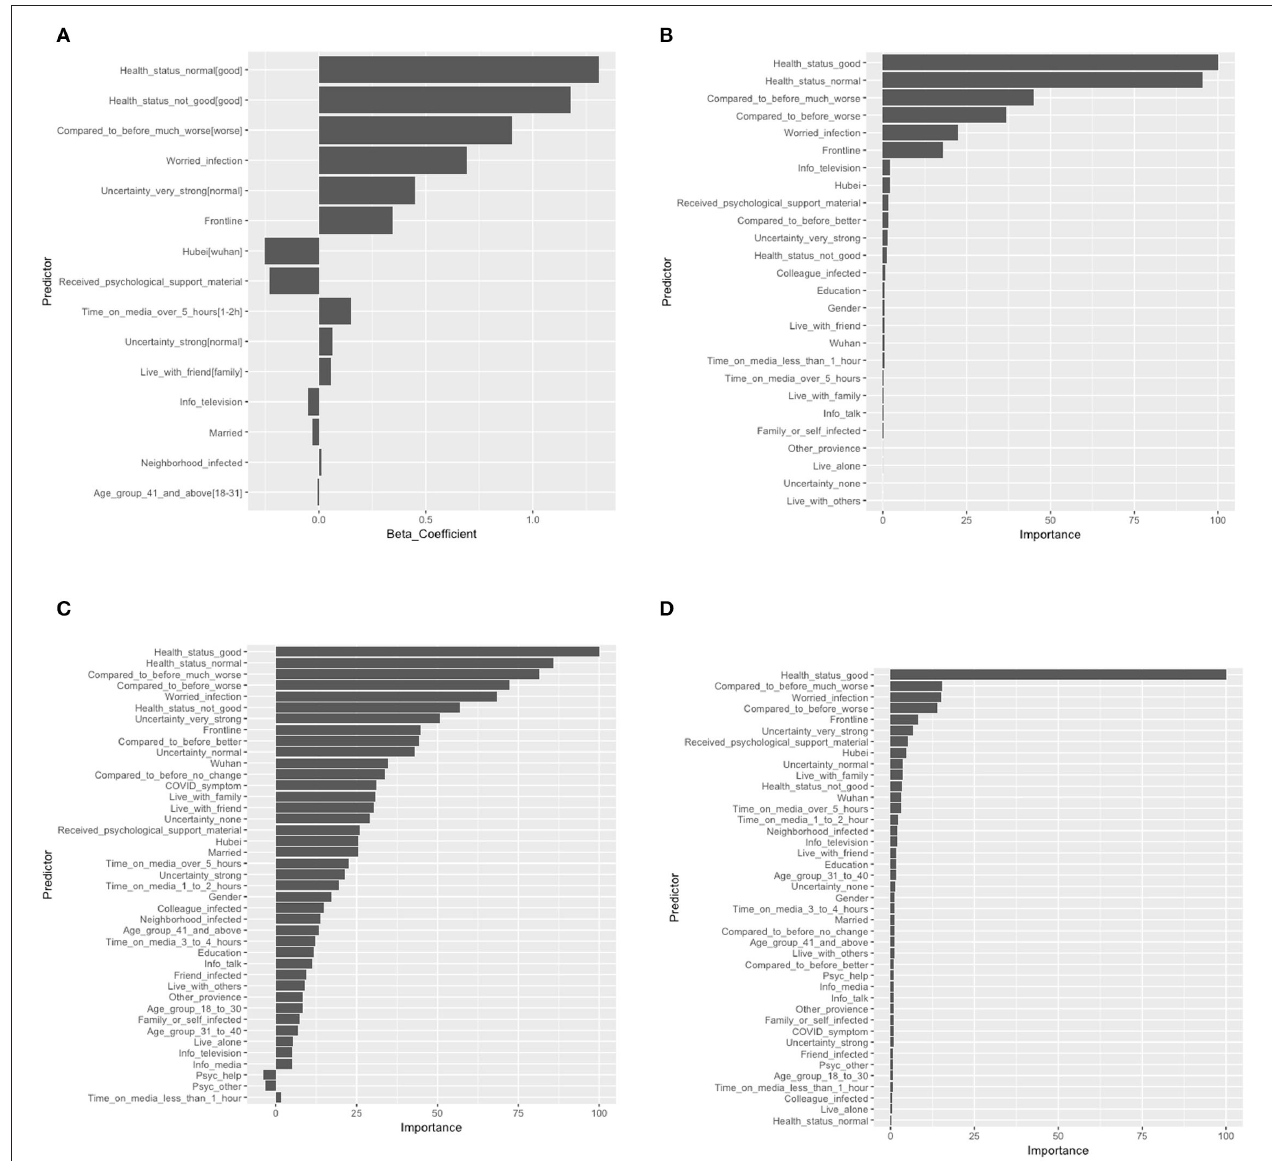
FIGURE 2 | Feature weights and contributions to the models: (A) logistic regression with LASSO; (B) decision tree; (C) random forest; and (D) gradient-boosting tree. The beta coefficient in logistic regression with LASSO and the importance of variables scaled by the maximum value of 100 in the decision tree, random forest, and gradient-boosting tree were shown. LASSO, Absolute shrinkage and selection operator; [], reference